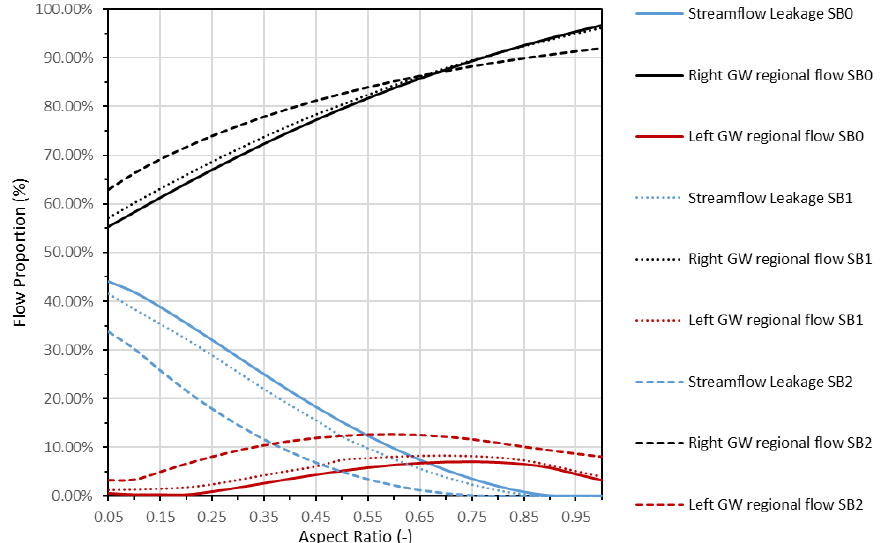
Figure 4. Evolution of the proportion of water in the pumping well with the aspect ratio and variation in the streambed properties (Q = 0.001 m 3 s − 1 m − 1 , Sim$1.2, Sim$1.5 and Sim$1.8).